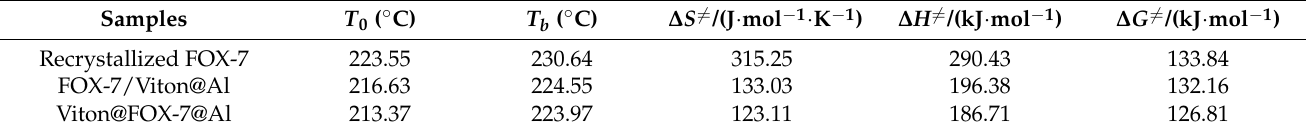
Table 2. Critical temperature of thermal explosion ( T b ) and thermal decomposition dynamics of samples.